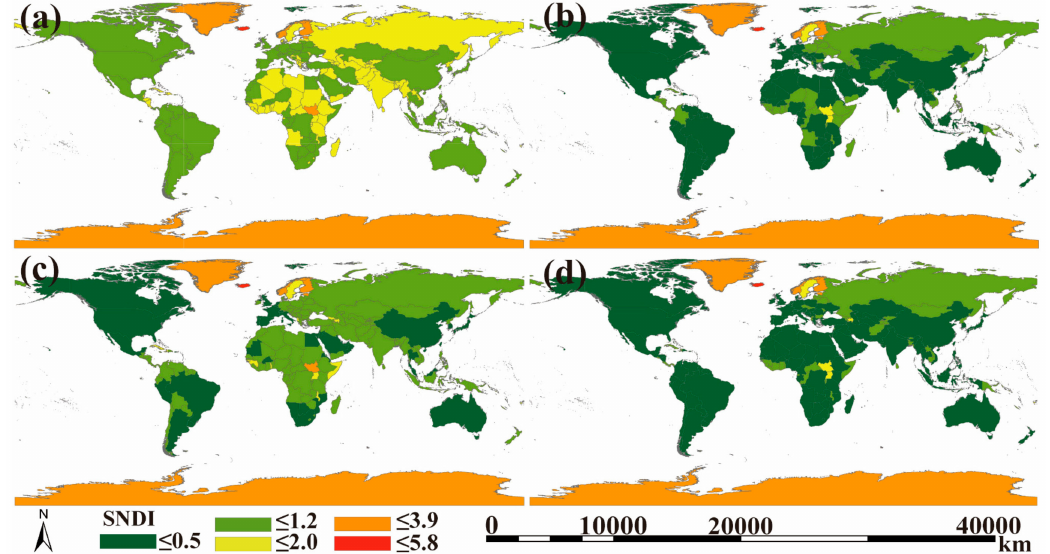
Figure 9. The SDNI of raw NTL and corrected NTL at national-scale. Note: ( a ) raw NTL; ( b ) the NTL corrected by traditional PIF-based model; ( c ) the NTL corrected by RSR-based model; ( d ) the NTL corrected by PBPIF-based